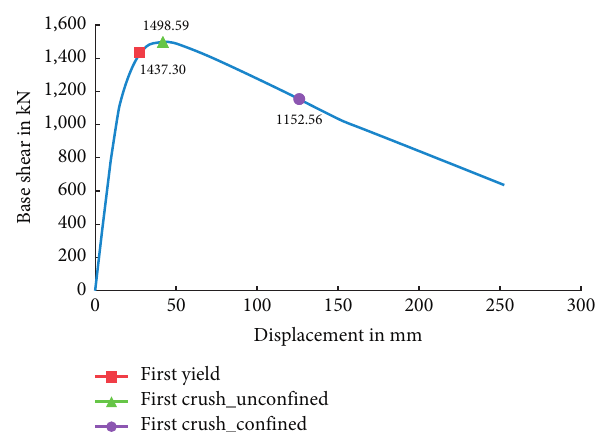
Figure 12: Damage pattern of open ground storey RC-infilled frame in Y direction.